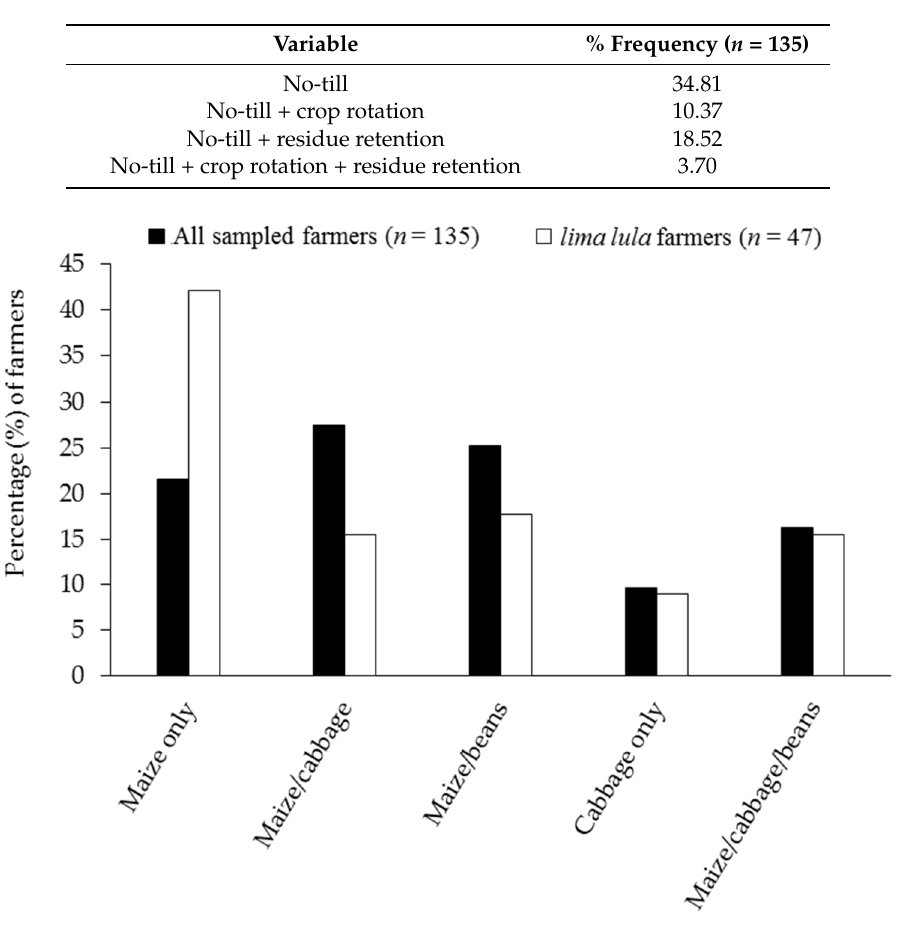
Figure 1. Frequencies (%) of crops and crop combinations grown by the entire sample of smallholder ( n = 135) and lima lula ( n = 47) farmers of the Eastern Cape Province.